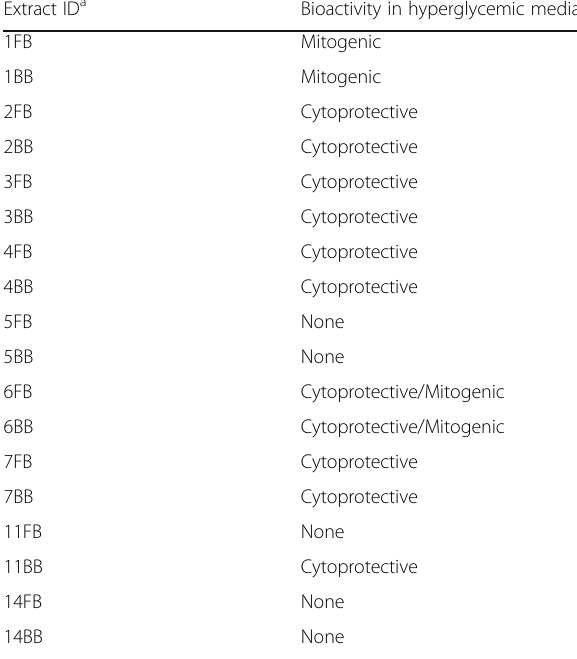
Table 2 Bioactivity of Picea mariana bark extracts in PC12-AC grown in hyperglycemic media Extract ID